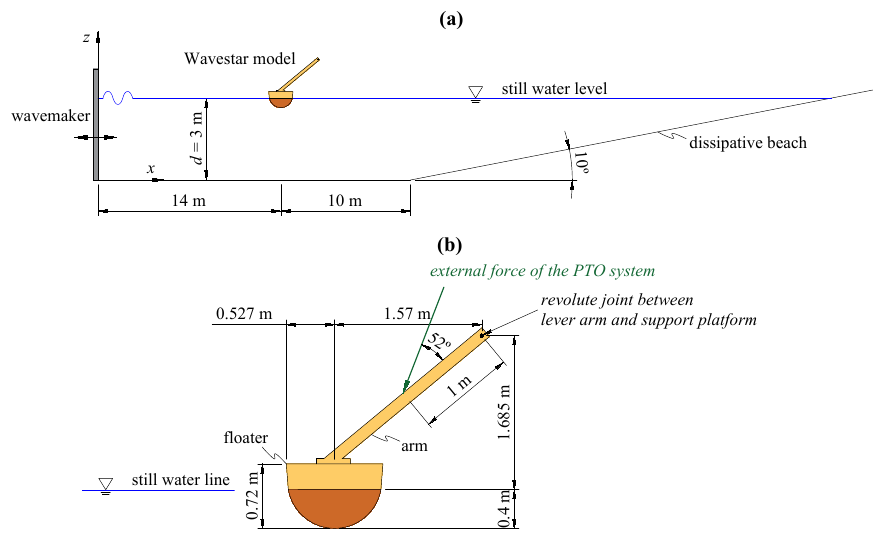
Figure 2. Schematic (side) view of the numerical set-up: ( a ) channel with the Wavestar model (not to scale); ( b ) dimensions (in m) of the Wavestar